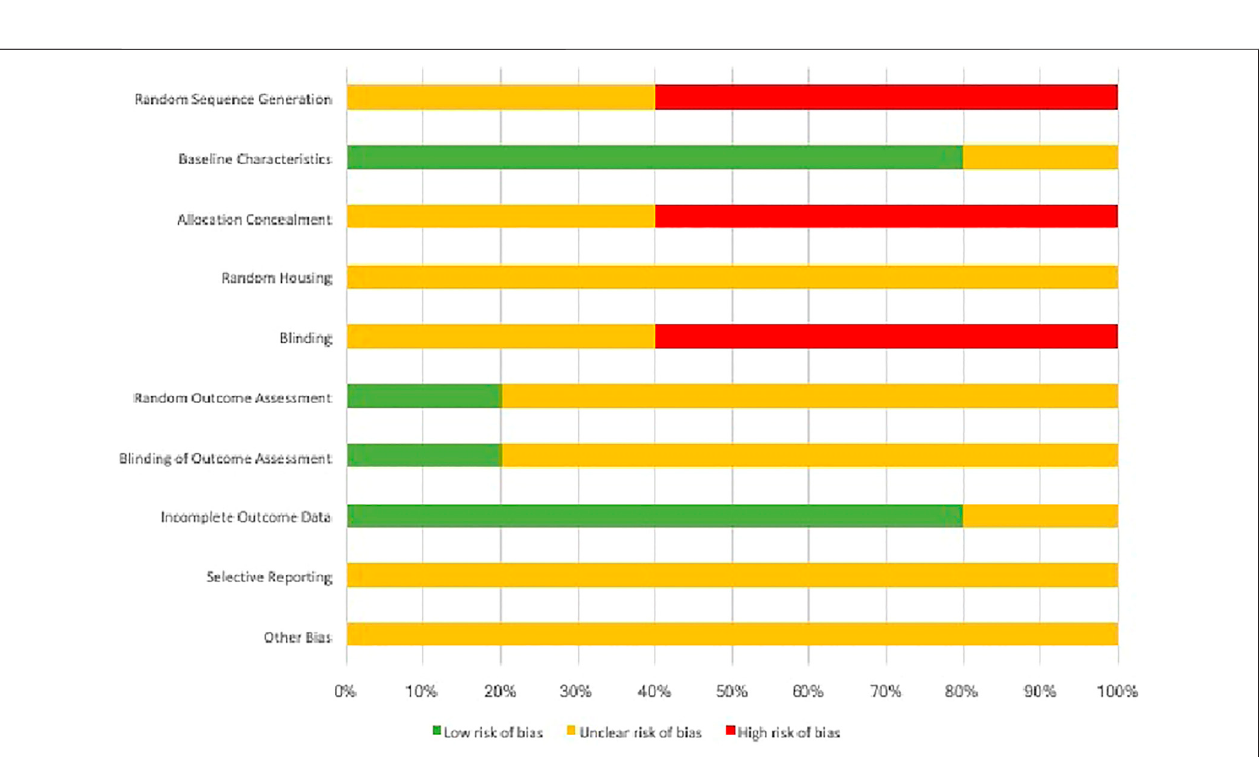
FIGURE 3 | Cumulative risk assessment of the included studies in the systematic review using individual items in SYRCLE RoB tool.